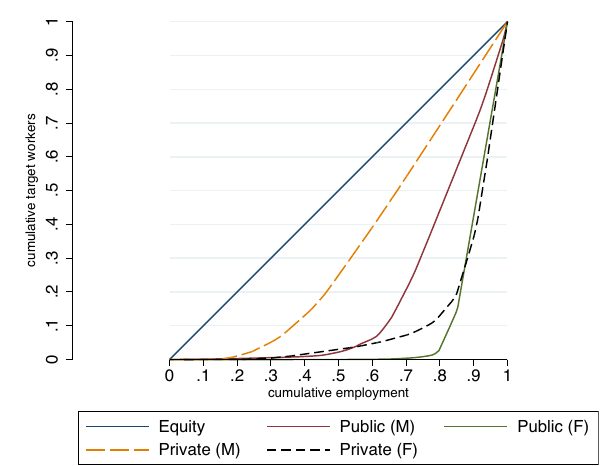
Fig. 5 Occupational segregation by gender and ownership. The fi gure shows the occupational segregation of male and female workers with respect to ownership of the organisation (public and private